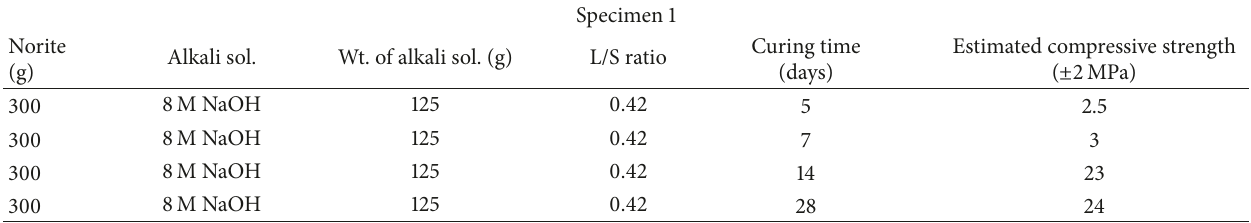
Table 4: Compressive strength of the binders without any additives. The specimens were cured at 87 ∘ C and ambient pressure.